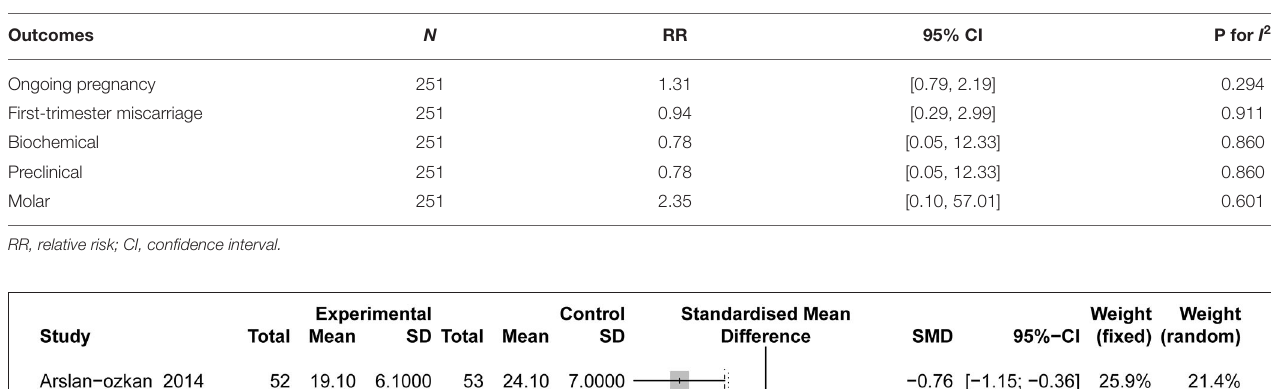
TABLE 2 | Results of failed pregnancy outcomes.